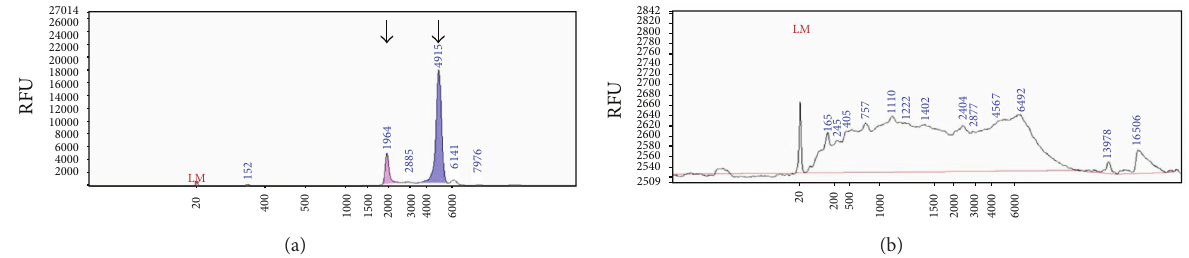
Figure 4: Differences in RNA size distribution (a) RNA of 1273/99 synovial sarcoma cells showing the characteristic ribosomal peaks of cellular RNA. The two prominent peaks (arrows) represent 18S (left) and 28S (right) ribosomal RNA. (b) RNA of microvesicles lack the characteristic ribosomal 18S and 28S peaks.